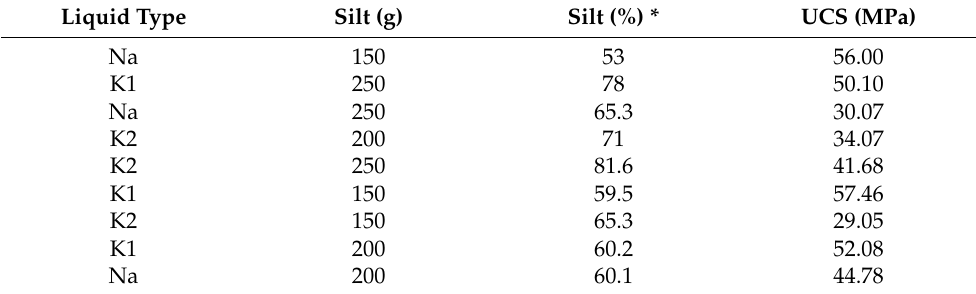
Table 12. UCS for samples produced with different amount of silt and liquid type.